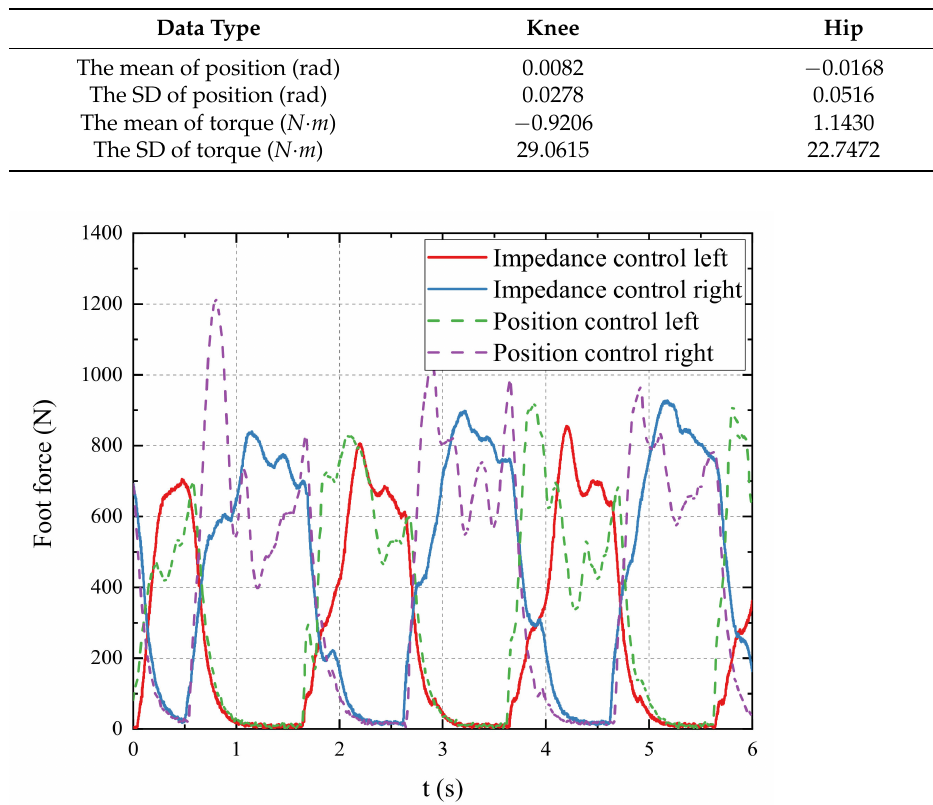
Table 6. Comparison of position and torque tracking errors.